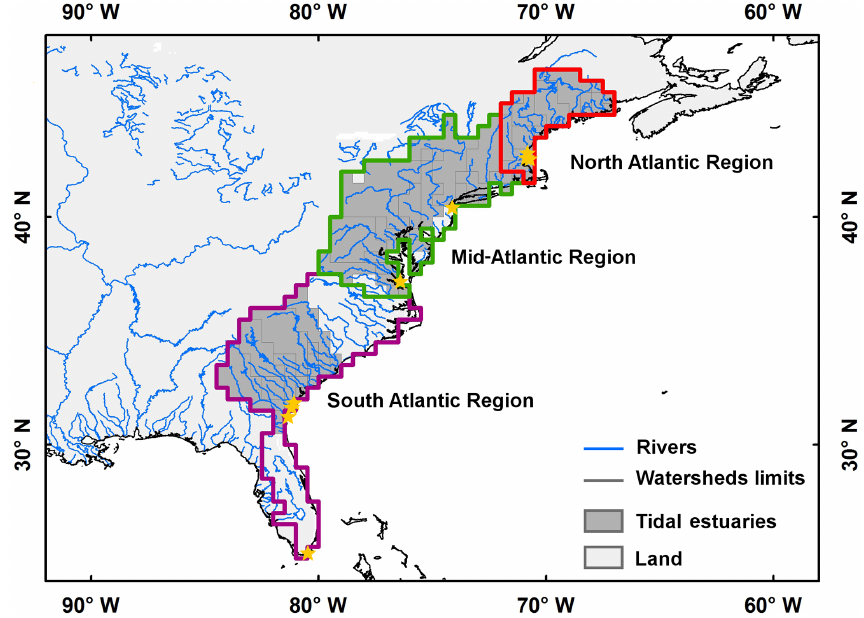
Figure 1. Limits of the 0.5 ◦ resolution watersheds corresponding to tidal estuaries of the US East Coast. Three subregions are delimited with colors, and orange stars represent the location of previous studies.